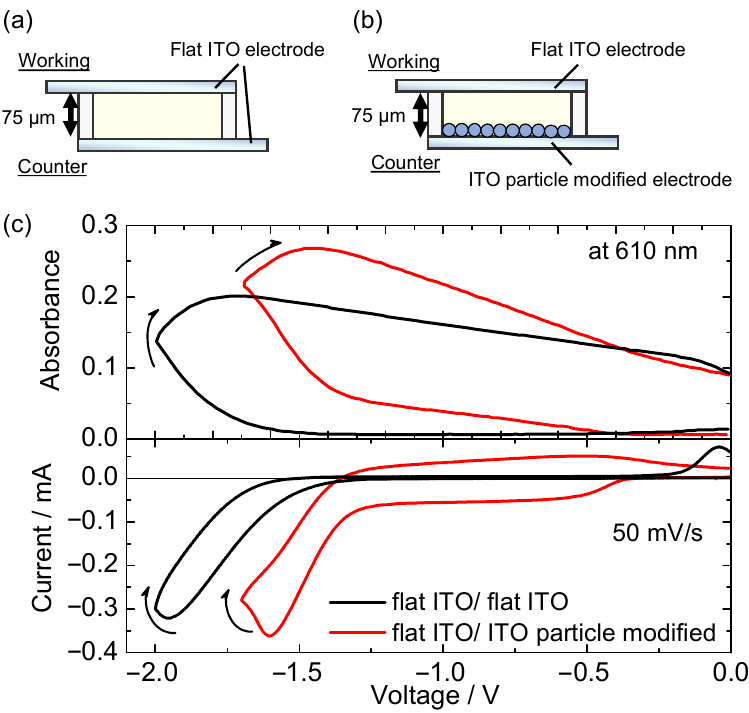
Figure 4. Schematic drawing of the device configuration of ( a ) flat ITO/flat ITO and ( b ) flat ITO/ITO particle-modified electrode. ( c ) CVs of two-electrode electrochemical device ( bottom ) and in situ absorption change at 610 nm ( top ). The electrolyte solution contains Eu(hfa) 3 (TPPO) 2 , DPA, HV 2+ , and supporting electrolyte. (Black line: two flat ITO electrodes, red line: flat ITO electrode and ITO particle-modified electrode)